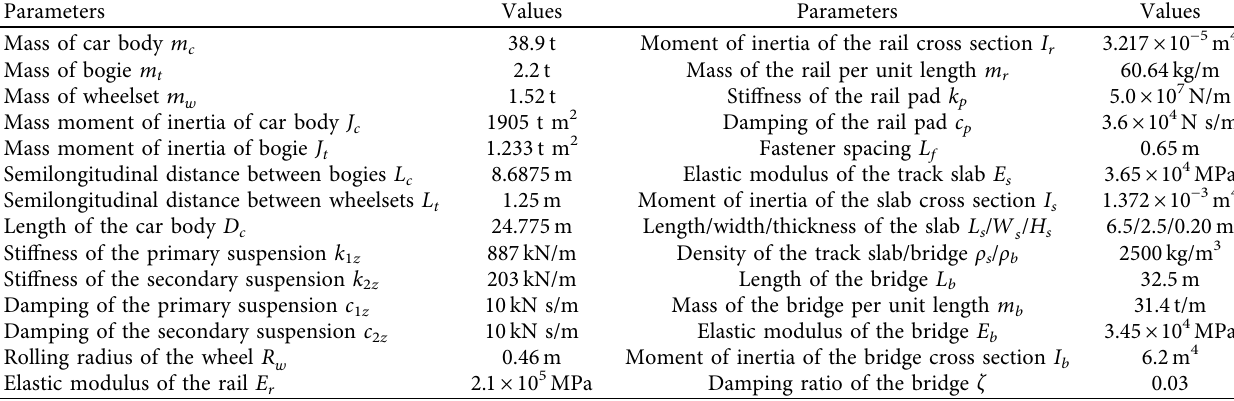
Table 1: Mechanical parameters of the railway vehicle, track, and bridge adopted in the simulation.